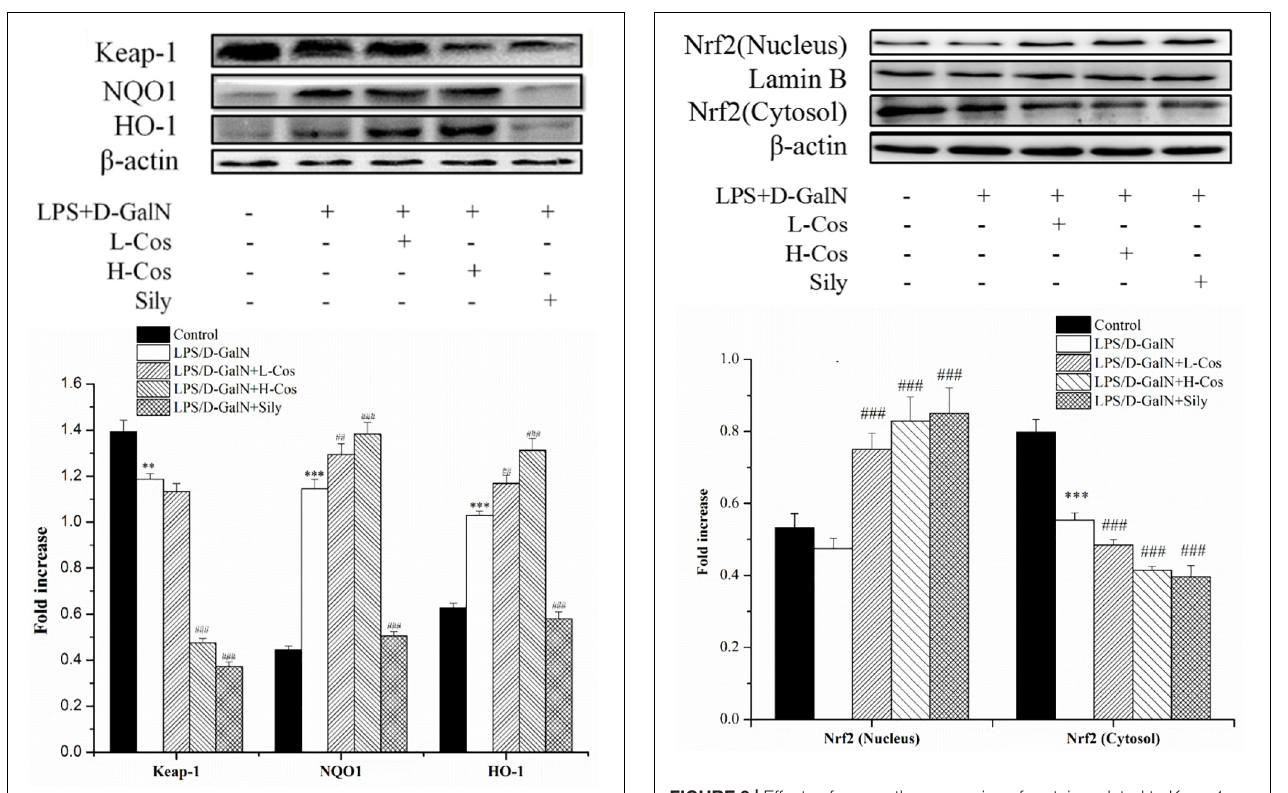
FIGURE 8 | Effects of cos on the expression Nrf2 signaling pathway. The expression of Nrf2 (cytosol and nucleus) were analyzed by western blot. The data represent the mean ± SD ( n = 10). The density values of the western blot were normalized for β -actin and Lamin B. ∗∗ P < 0.01, ∗∗∗ P < 0.001 vs. control group; ### P < 0.001 and ## P < 0.01 vs. LPS/ D -GalN group.